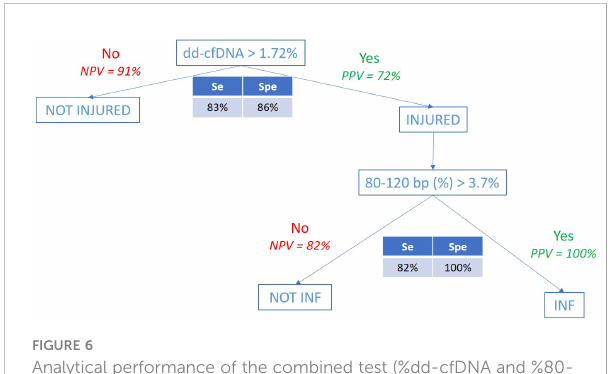
FIGURE 6 Analytical performance of the combined test (%dd-cfDNA and %80- 120bp